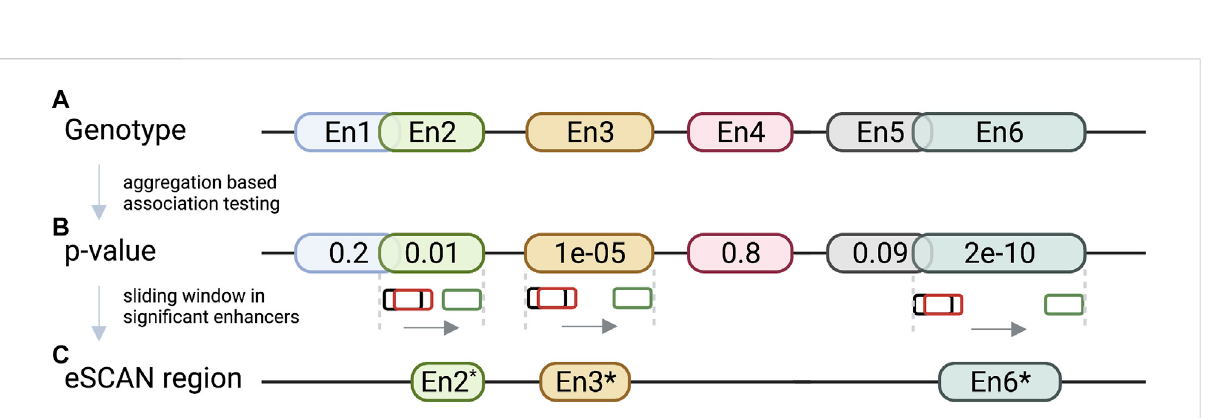
FIGURE 5 eSCANwork fl ow. (A) eSCANtakesgenotypeandphenotypeaswellasalistofprede fi nedenhancer(En1-En6intheillustration)regionsasinput. (B) Aggregation-based association tests are performed in the enhancer-screening step to identify signi fi cant enhancer(s). In this illustration, En2 (green), En3 (yellow), and En6 (turquoise) are deemed signi fi cant. (C) eSCAN performs dynamic sliding window scanning within the signi fi cant enhancer region(s) to further narrow down the associated region. For example, En2* is the associated sub-region within En2 after narrowing down via dynamic scanning. Similar for En3* and